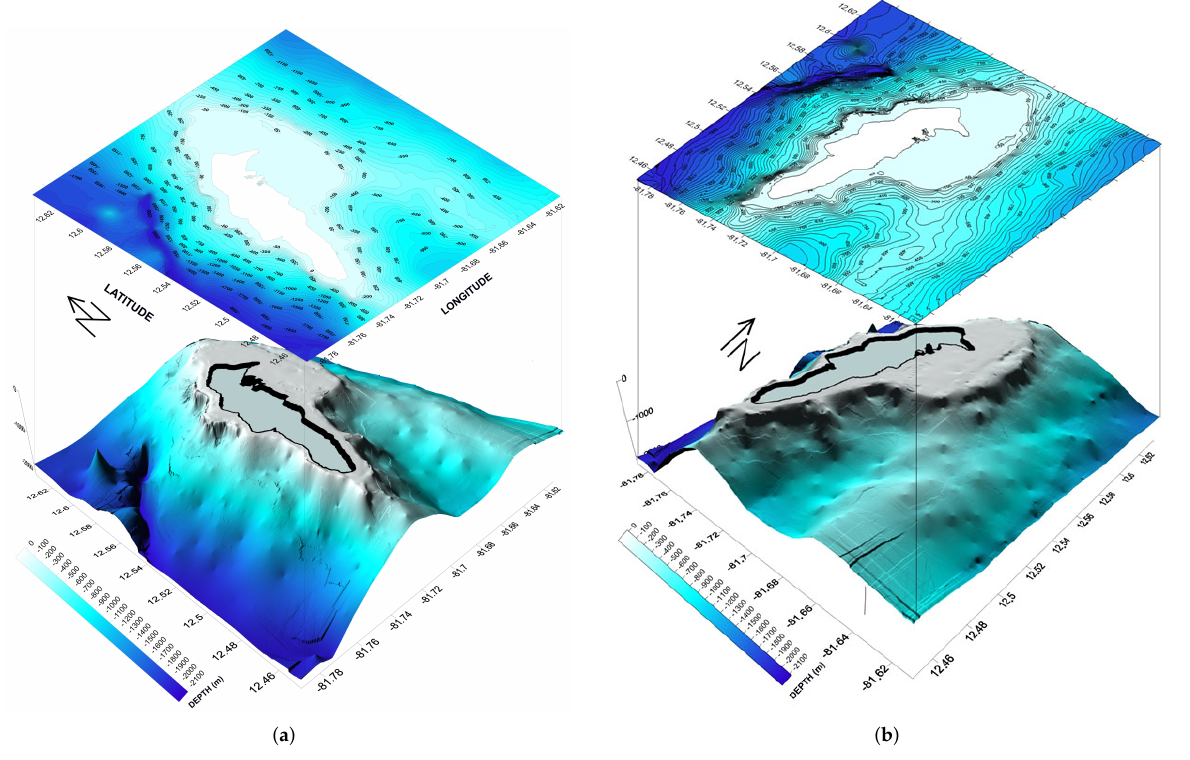
Figure 7. Bathymetry of San Andrés. ( a ) Western. ( b )